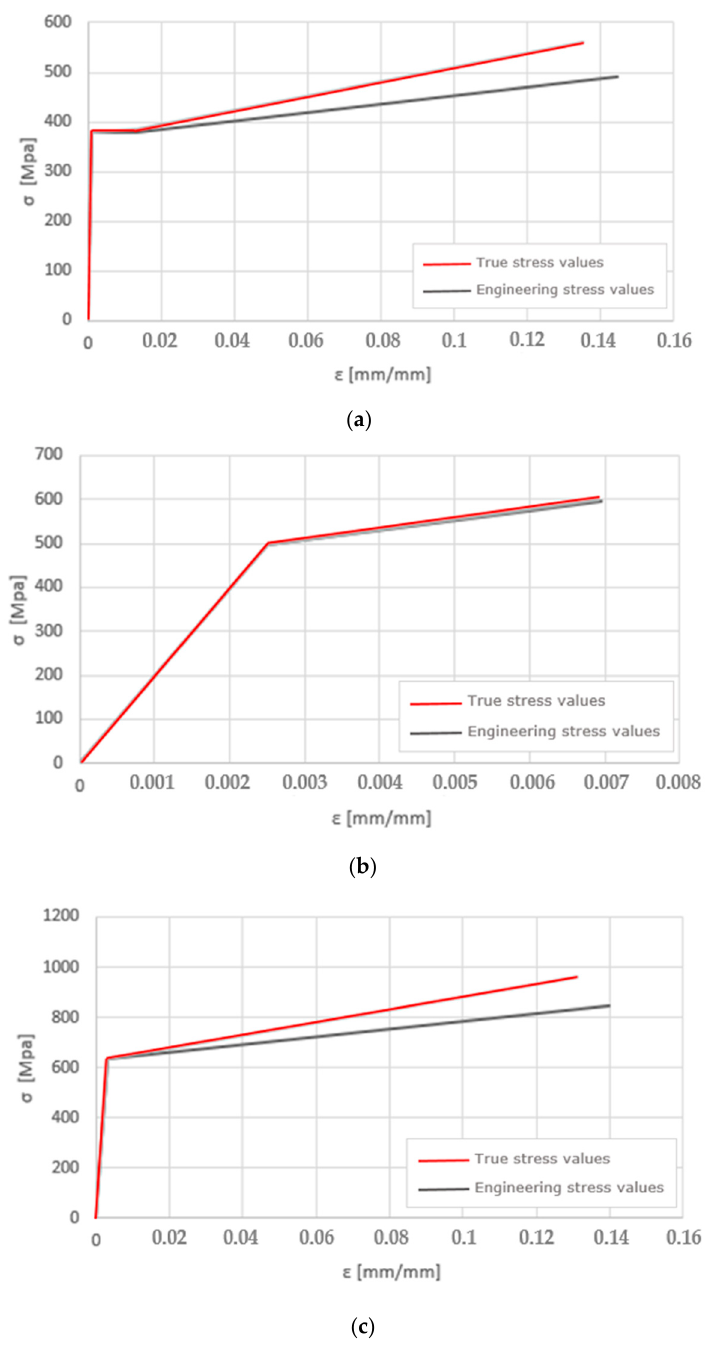
Figure 7. Relation stress-strain of materials used: ( a ) ASTM A36 material, ( b ) ASTM A500 Gr. B material and ( c ) ASTM A325 material.